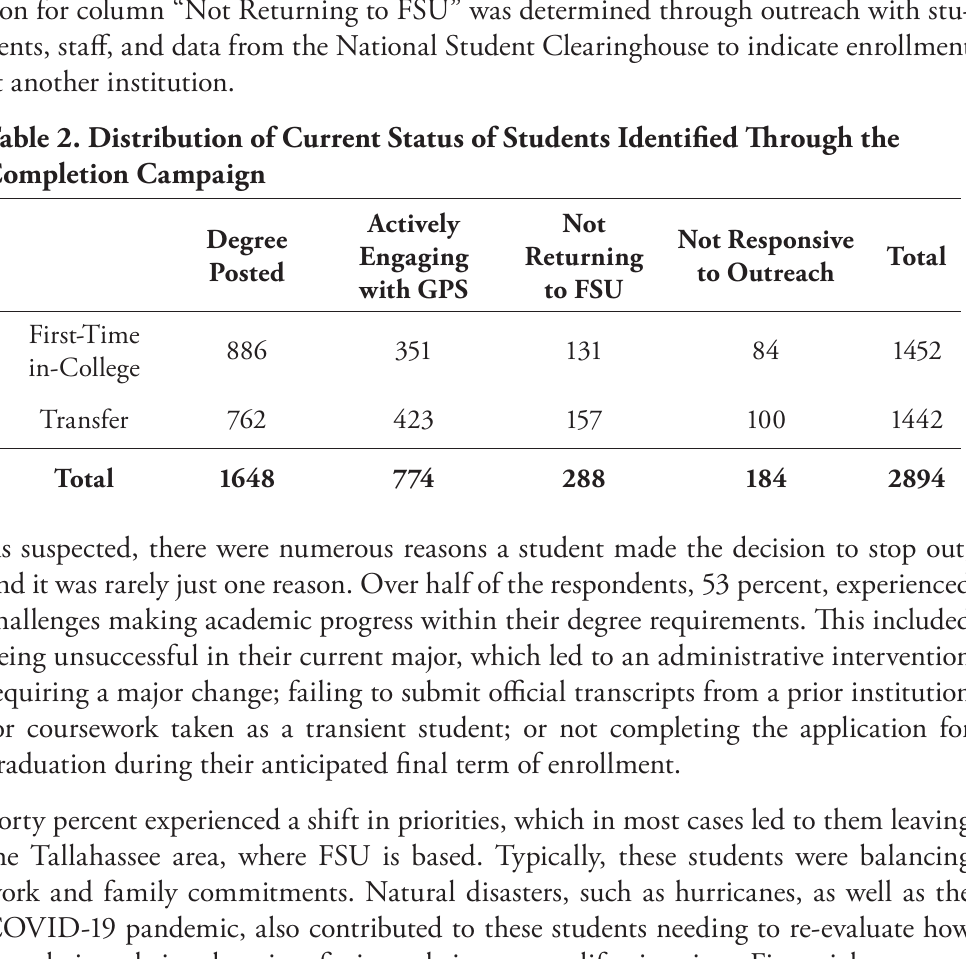
Table 2. Distribution of Current Status of Students Identified Through the Completion Campaign